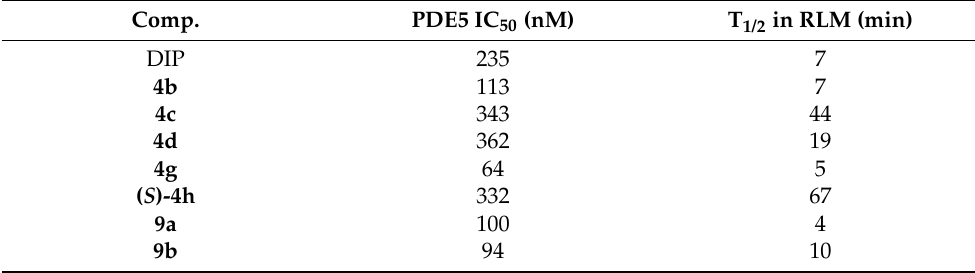
Table 4. The metabolic stability of typical compounds in RLM.